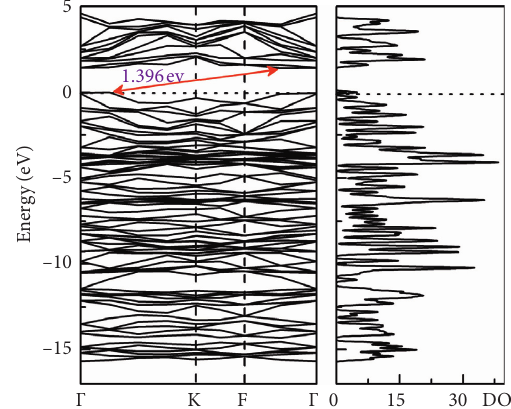
Figure 2: Electronic structure of borophene.